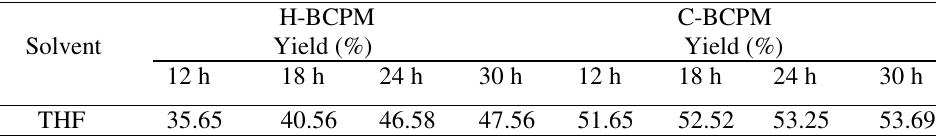
Table 3 . Percentage yield of homo and copolymaleimide in different time.